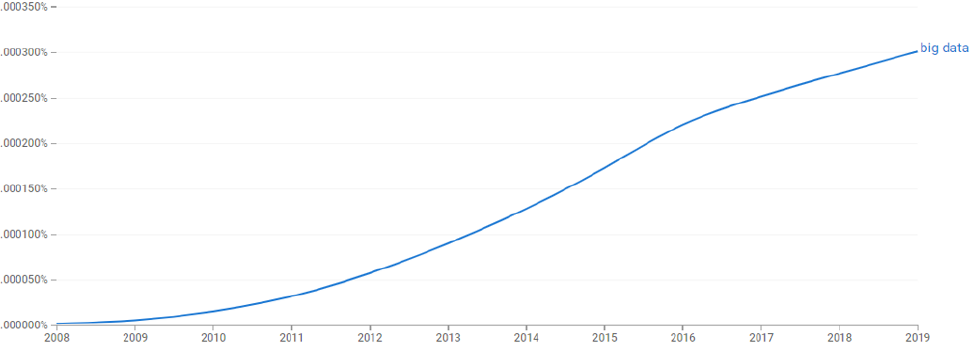
Figure 1. Evolution of the term “big data” (Data source: Google Books Ngram Viewer, available at http://books.google.com/ngrams, retrieved 25 August 2022).